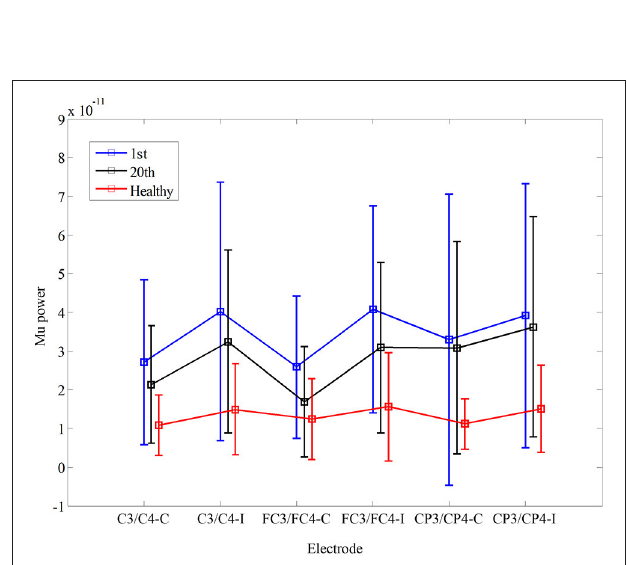
FIGURE 3 | Comparison of mu power during non-biological observation at six electrodes (C3, C4 FC3, FC4, CP3, CP4) among healthy subjects and stroke subjects at pre- and